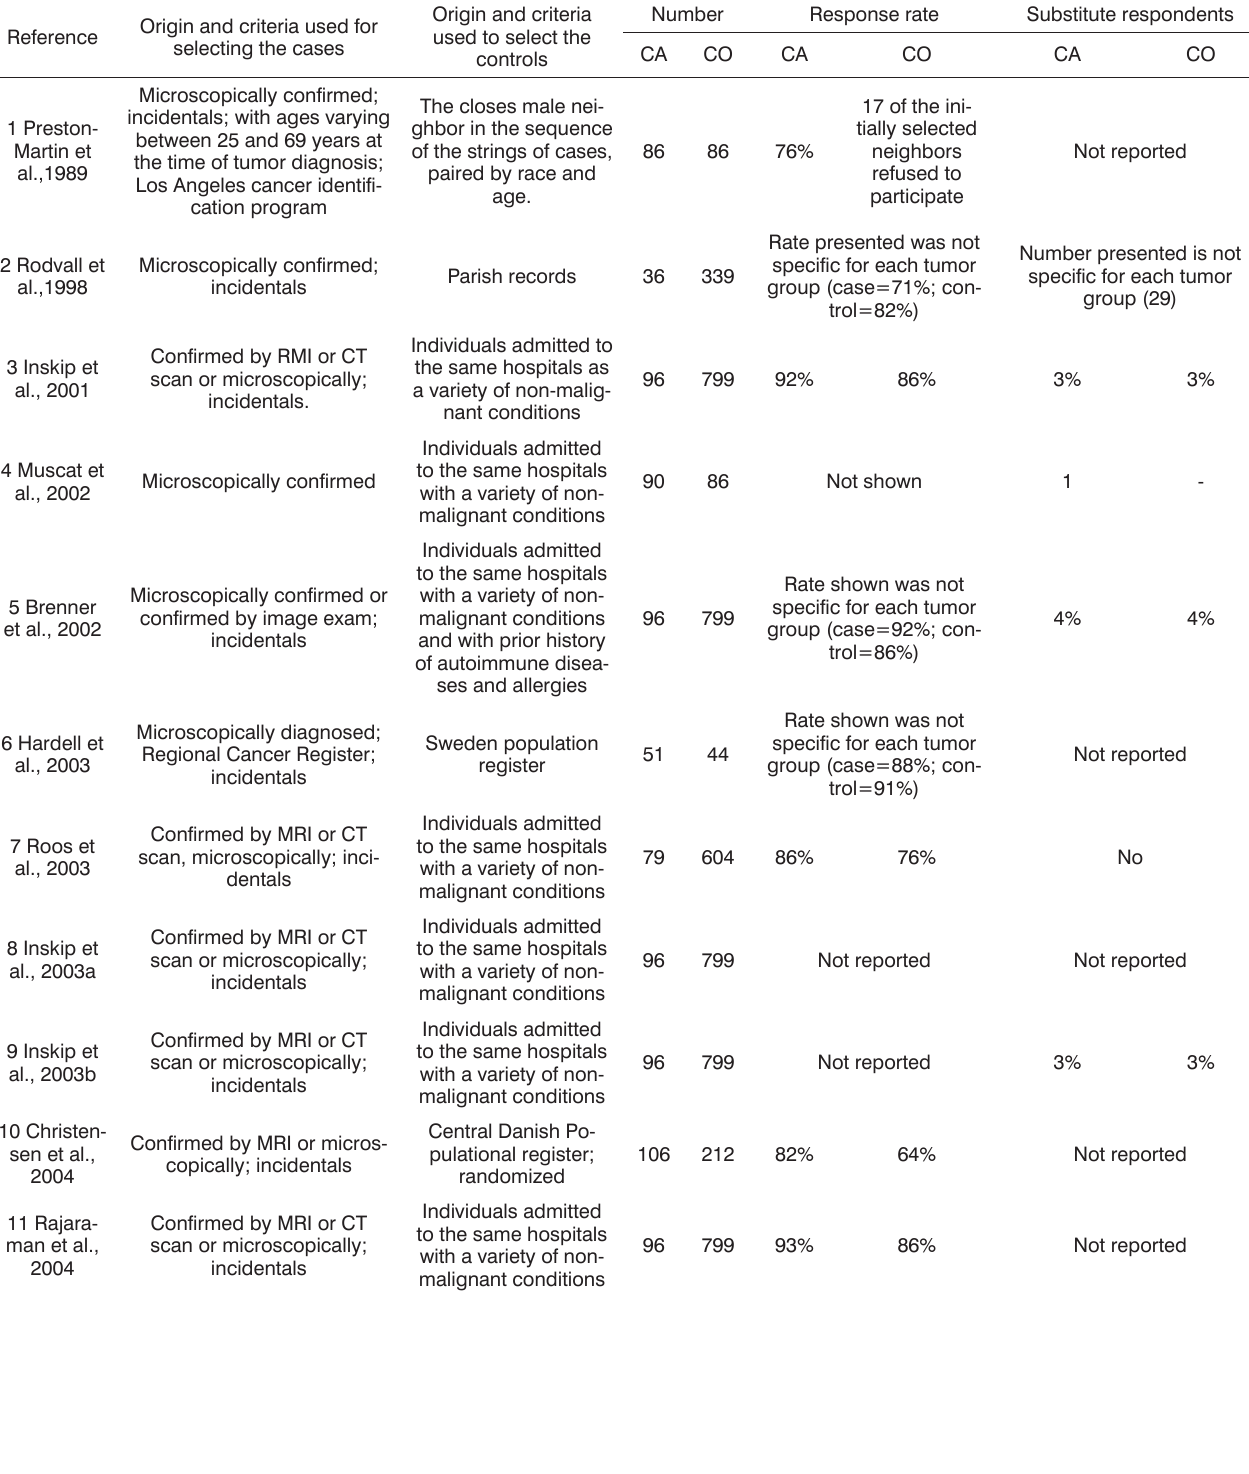
Table 2. Characteristics of the cases and controls from the studies which investigated risk factors associated with vestibular nerve schwanno- ma